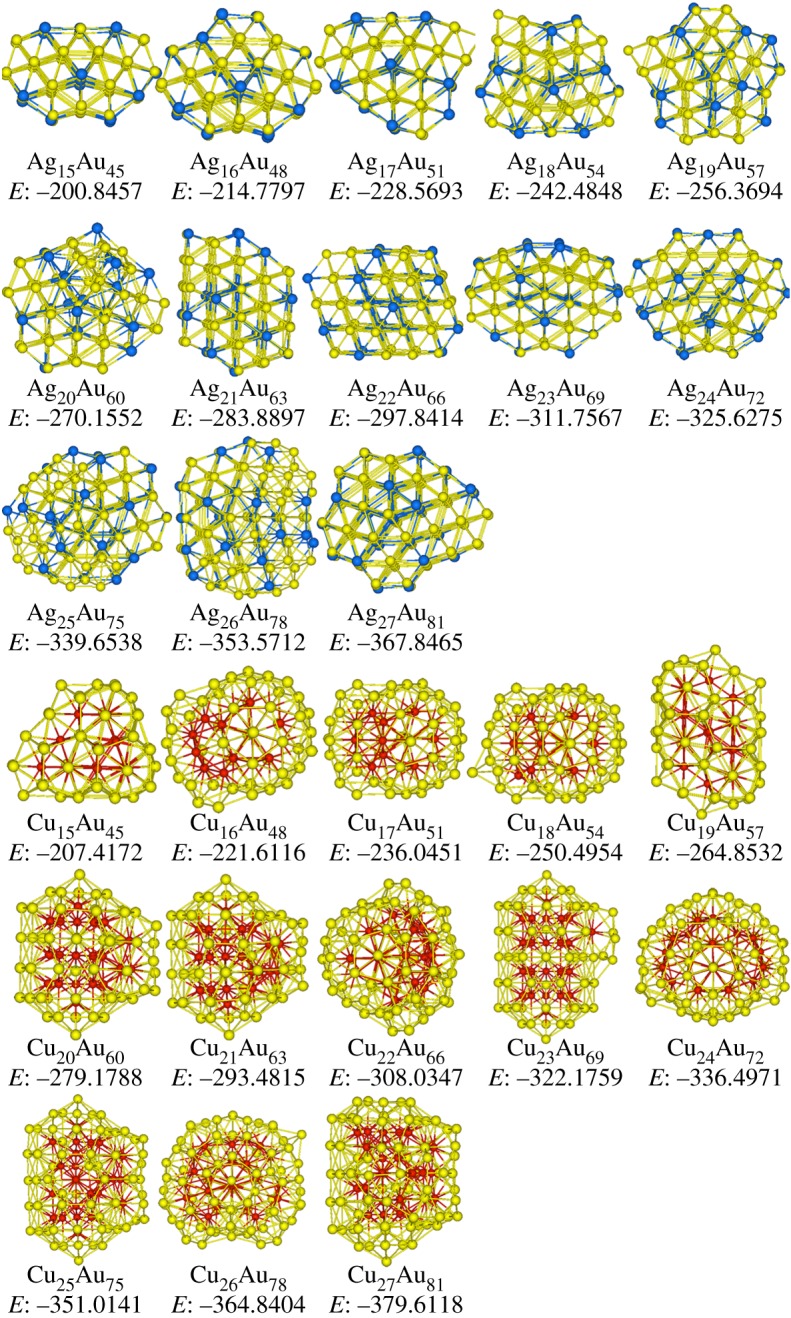
Stable structures of AgnAu3n and CunAu3n (n = 15–27) clusters, and Cu, Ag and Au atoms are represented by red, blue and yellow spheres, respectively, and the potential energies E (eV) are also added.